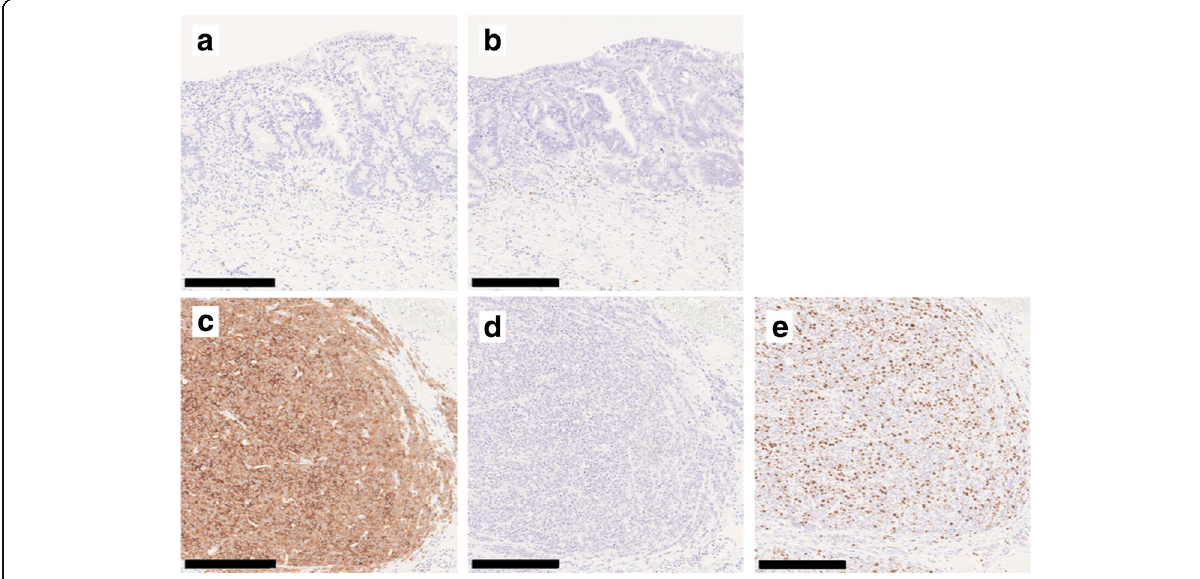
Fig. 5 Immunohistochemical findings. Immunohistochemically, adenocarcinoma cells were negative for synaptophysin ( a ) and chromogranin A ( b ), while the round-shaped carcinoma cells were diffusely positive for synaptophysin ( c ), but negative for chromogranin A ( d ). The Ki67 labeling index was 50% ( e ). All scale bars — 250 μ